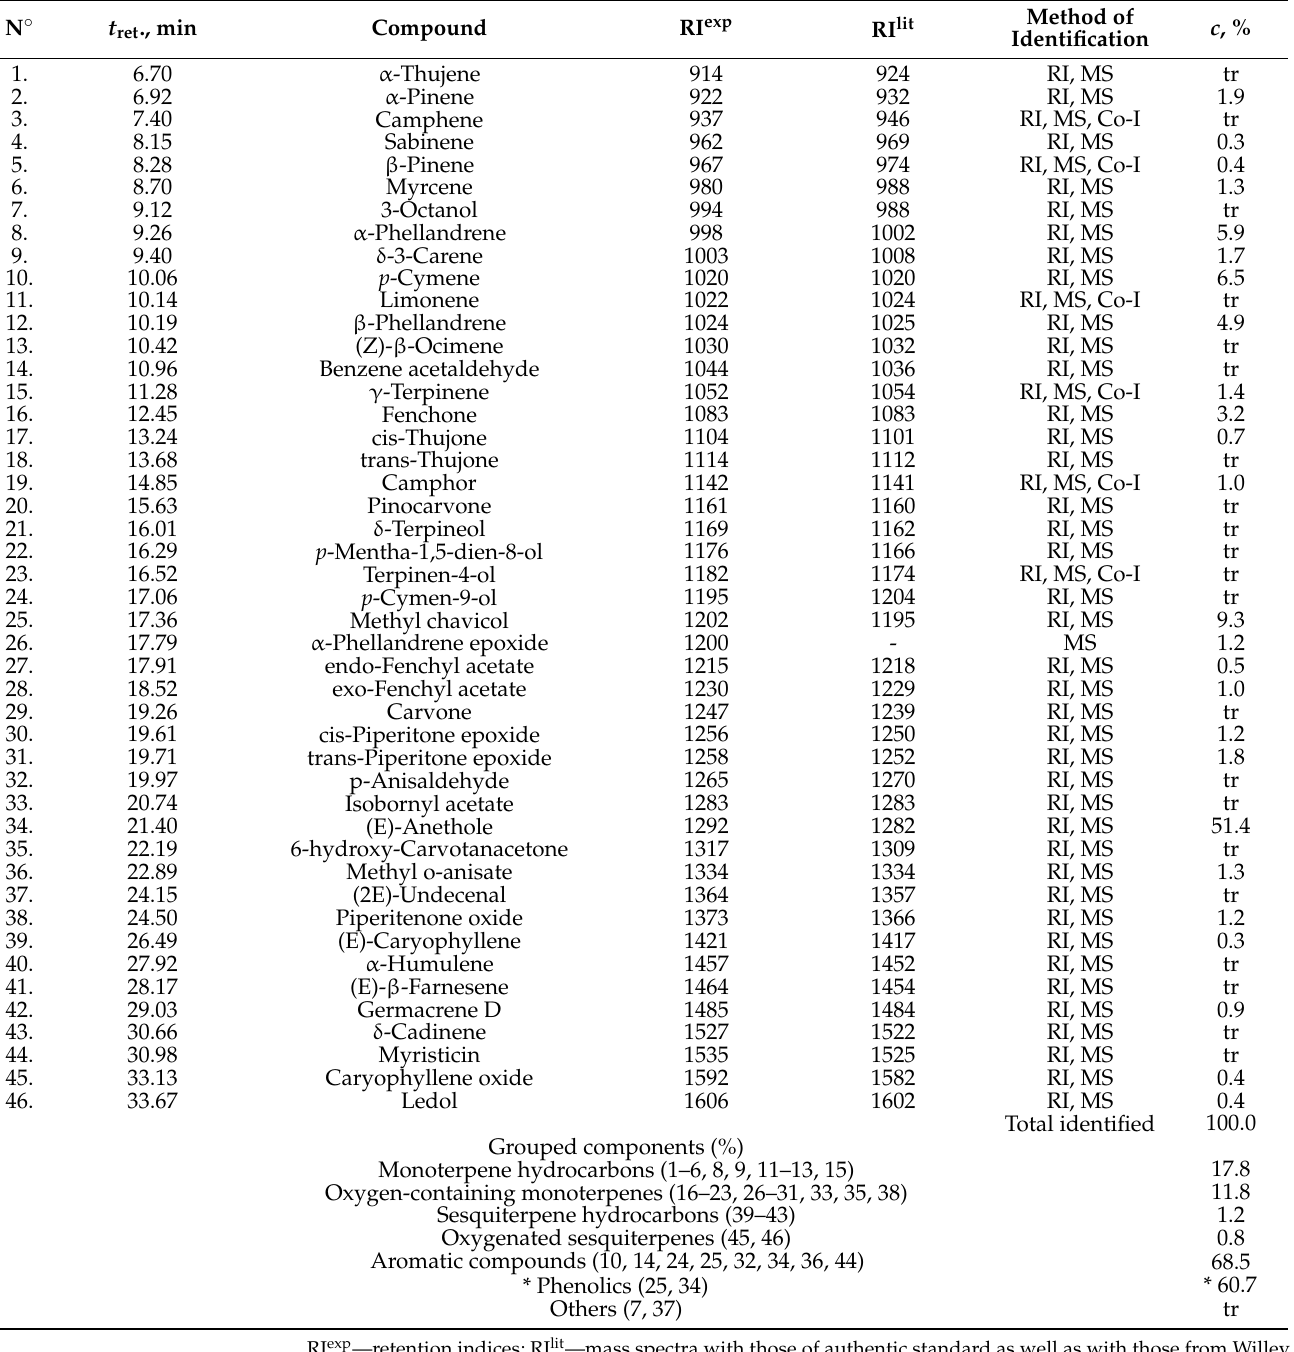
Table 3. Chemical composition of essential oils isolated from wild fennel